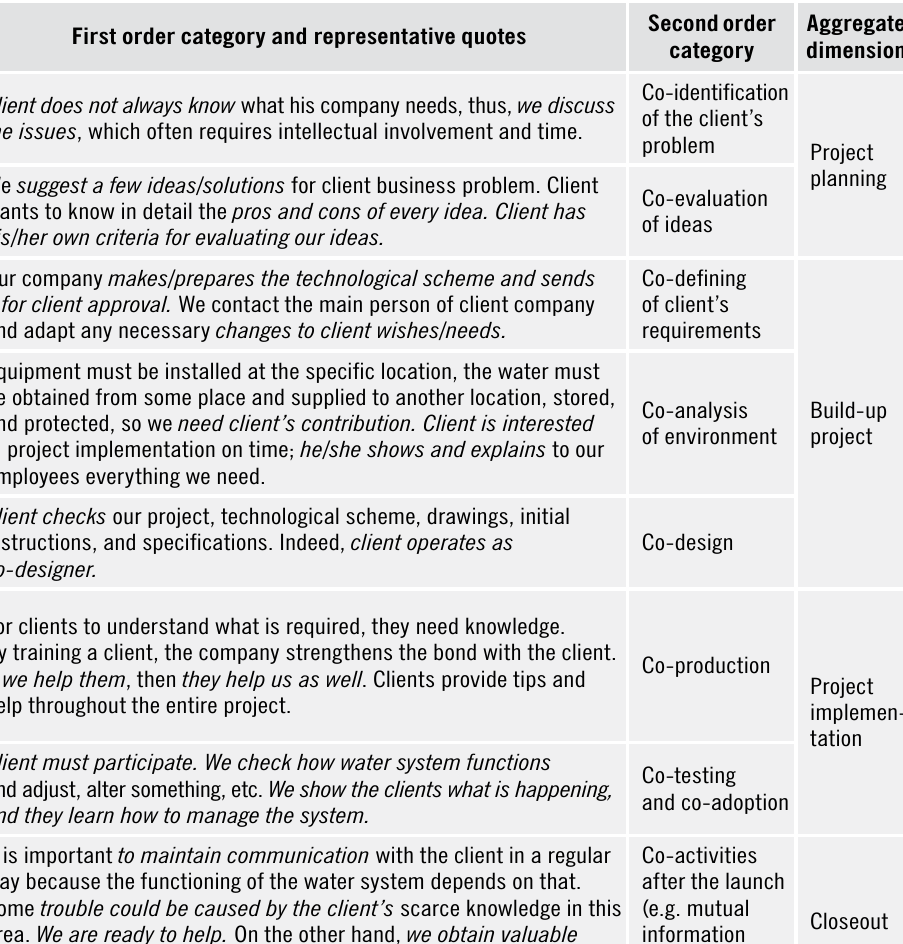
Table 7. Company and client value co-creation activities in engineering